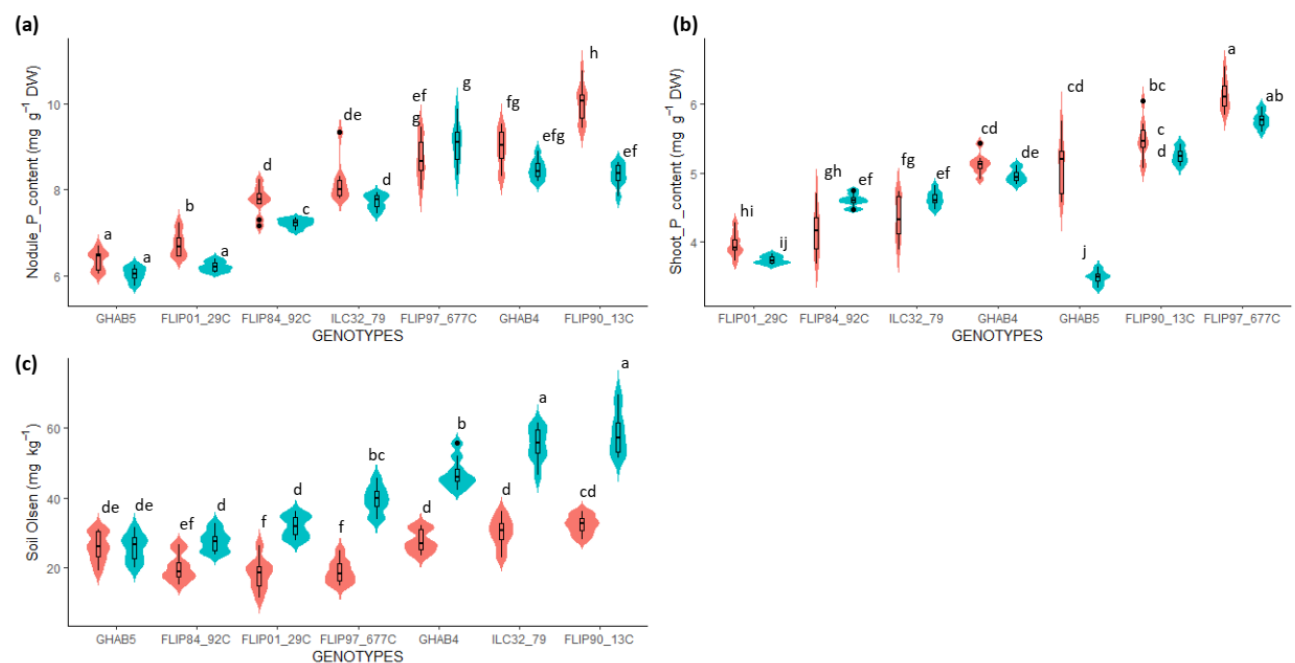
Figure 5. Evaluation of the phosphorus acquisition of the seven chickpea cultivars grown under low-P availability field conditions during two growing seasons. Nodule ( a ), shoot ( b ) and soil ( c ) phosphorus content are represented. Data were recorded from nine replicates for each of the two growing seasons from 2018 (red) to 2019 (blue). Letters identify significantly different groups, according to the Tukey test for the multiple mean comparisons at p = 0.05. DW, dry weight.